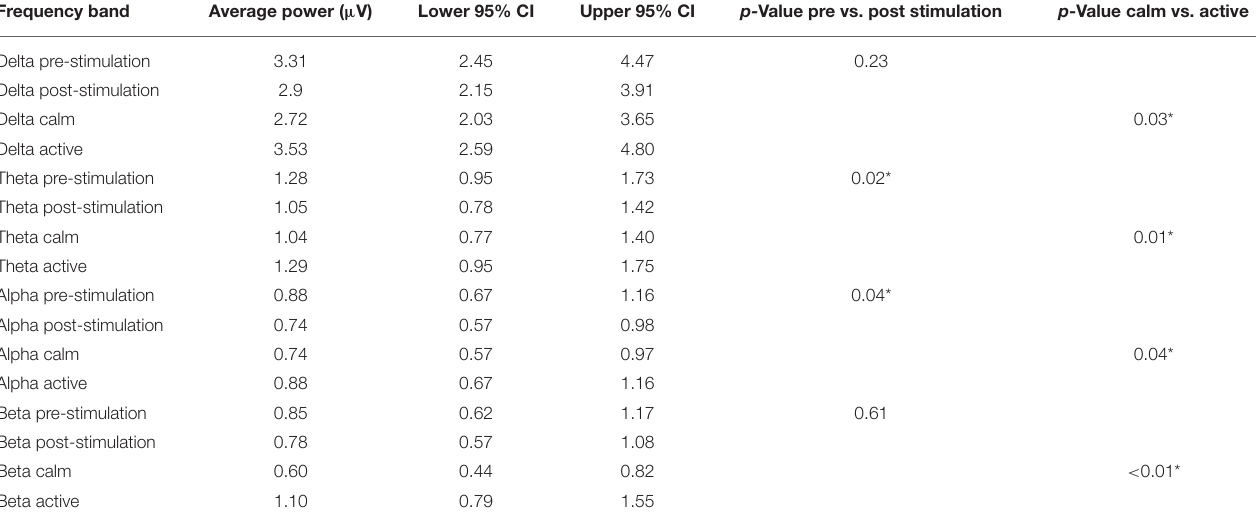
TABLE 2 | Average power per channel per frequency band with upper and lower confidence intervals for the pre- and post-stimulation periods and for the calm vs active states. Frequency band p- Value pre vs. post stimulation p -Value calm vs.